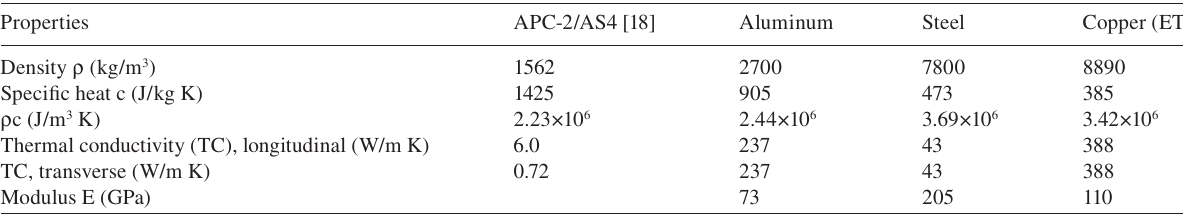
Table 1 Input parameters for heat transfer calculation.